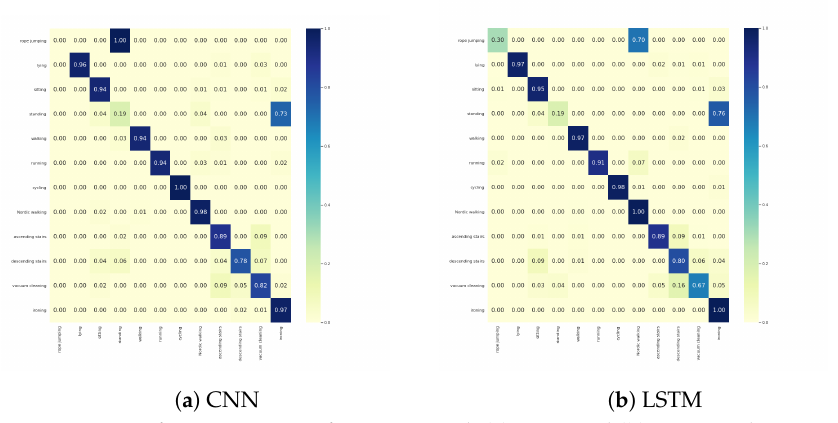
Figure A7. Confusion matrices of PAMAP2 with ( a ) CNN and ( b ) LSTM architectures. The confusion matrix for WISDM and Skoda dataset for LSTM and Conv LSTM archi- tecture respectively is given in Figure A8.